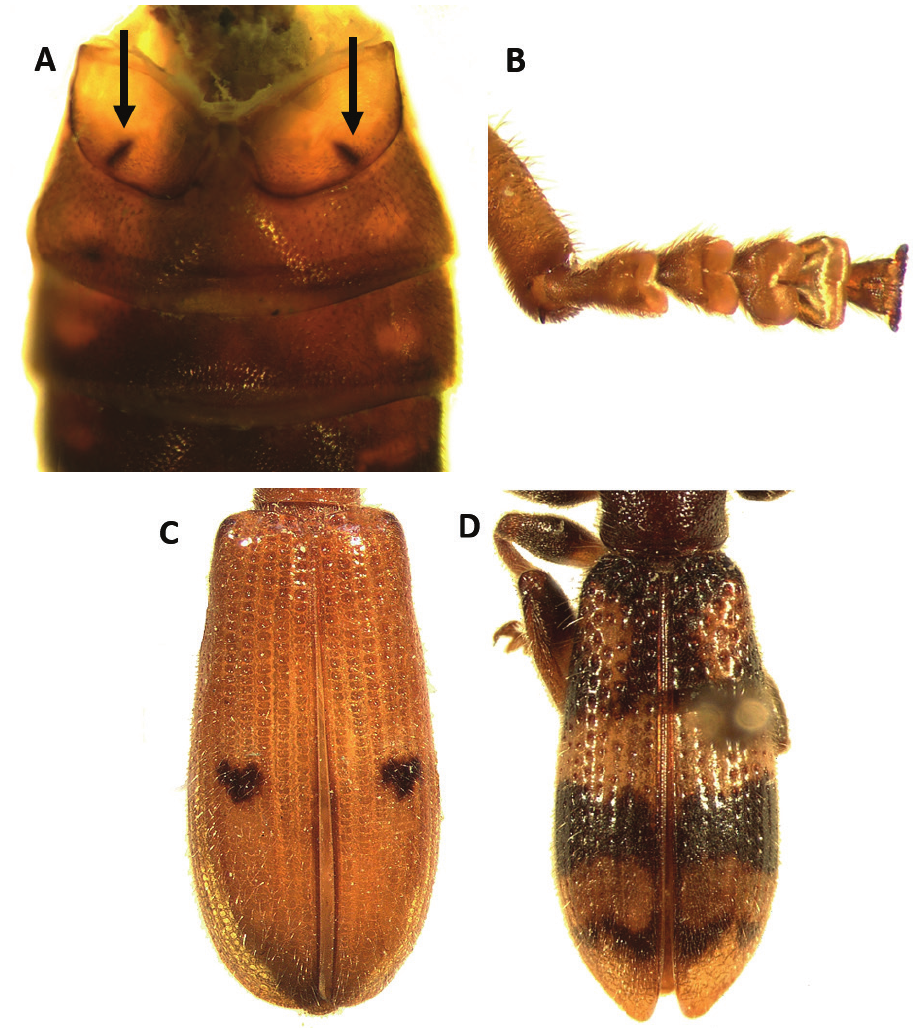
Figure 13. A Abdomen of Cymatodera balteata , arrows indicate first abdominal segment bearing a pair of carinae B Protarsomere of Cymatodera tuta C–D Elytral punctations of C C ymatodera bipunctata D Cymatodera grossa